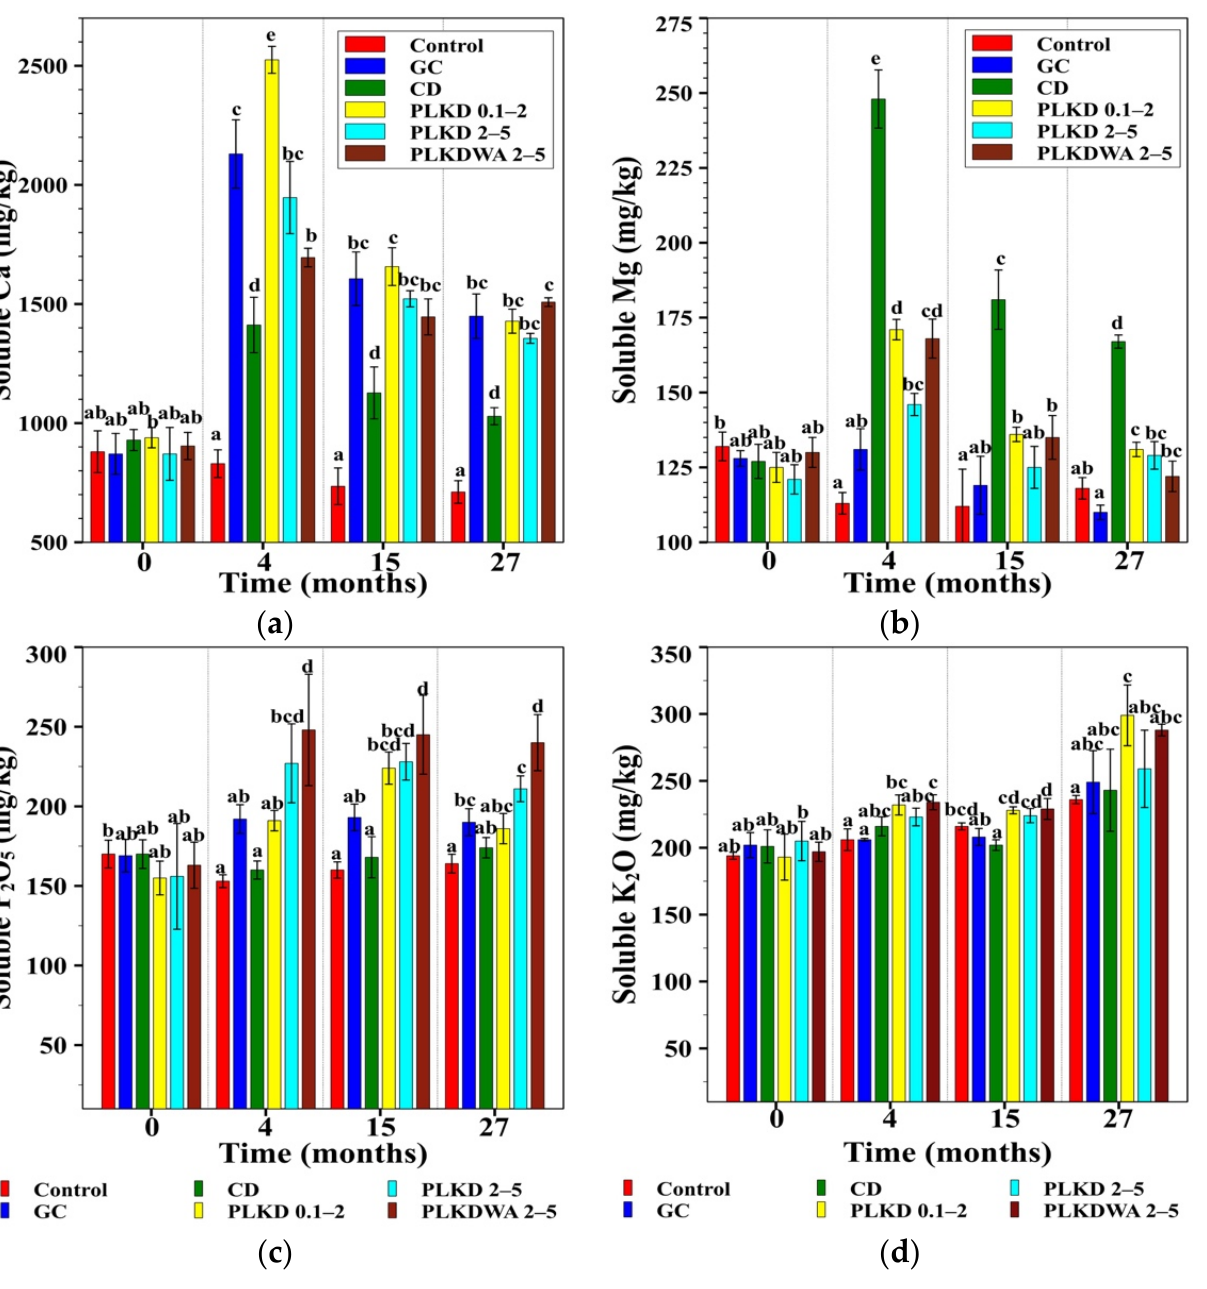
Figure 4. ( a ) Soluble Ca, ( b ) soluble Mg, ( c ) soluble P 2 O 5 , and ( d ) soluble K 2 O in the soil during the 3-year liming experiment. Soluble is defined as being available for plants. Lowercase letters indicate a significant difference according to Duncan’s multiple range test (DMRT p ≤ 0.01).